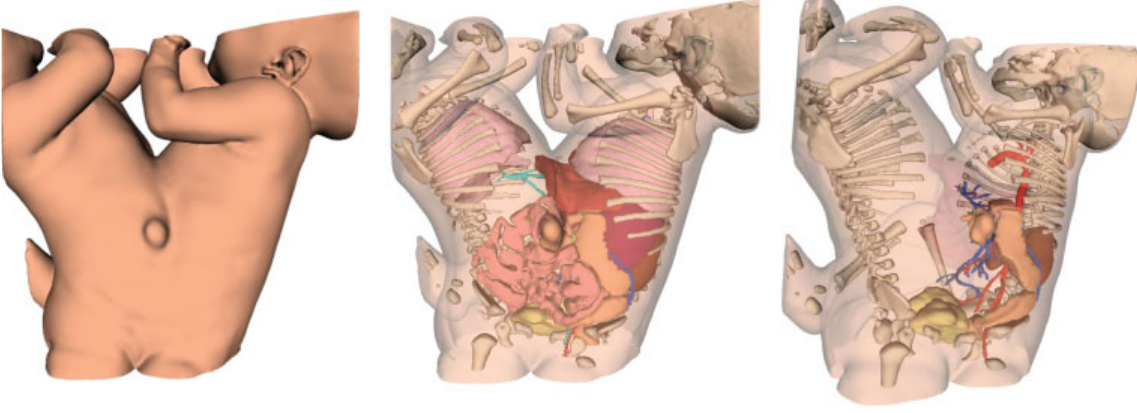
Fig. 1 Electronic three-dimensional (3D) model for the ventrally fused conjoined twins (omphaloischiopagus).